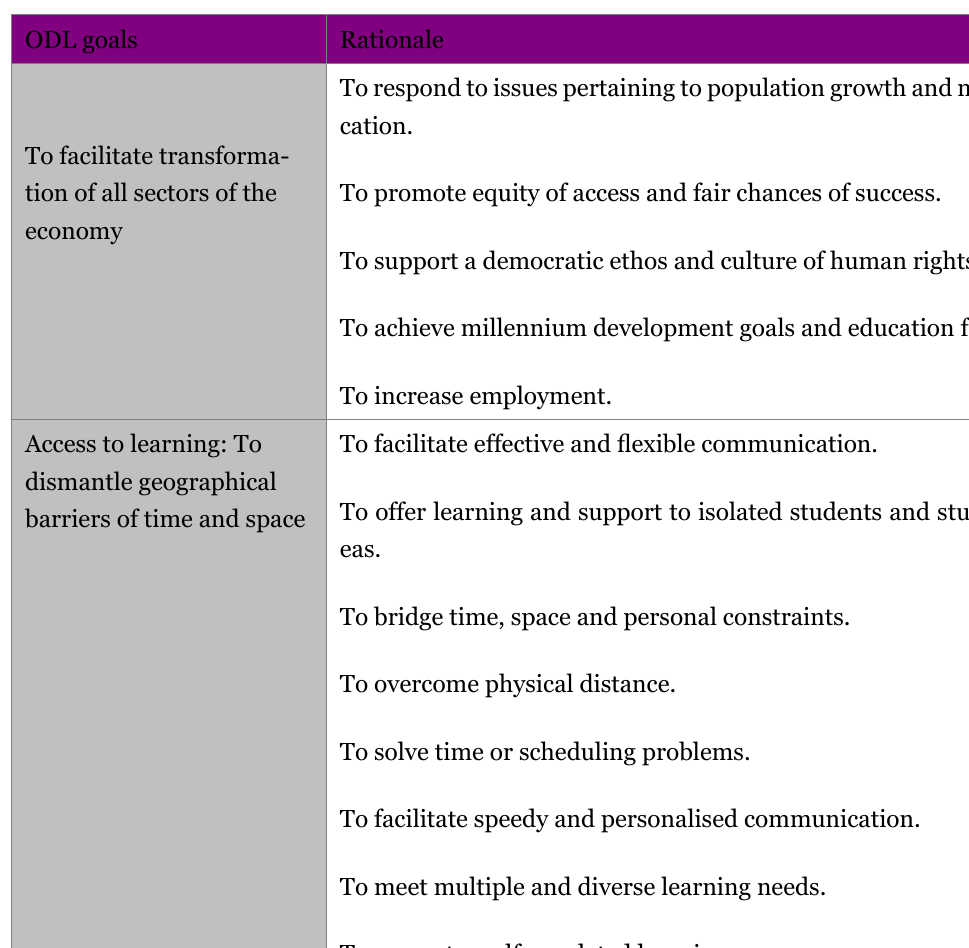
Table 3 Goals and Rationale for ODL ODL